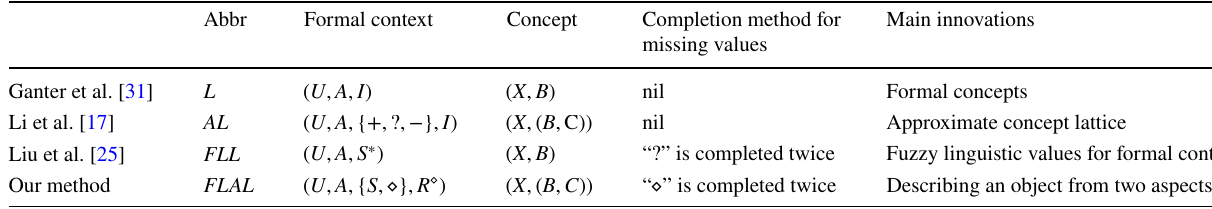
Table 7 Comparison of different concept lattice construction